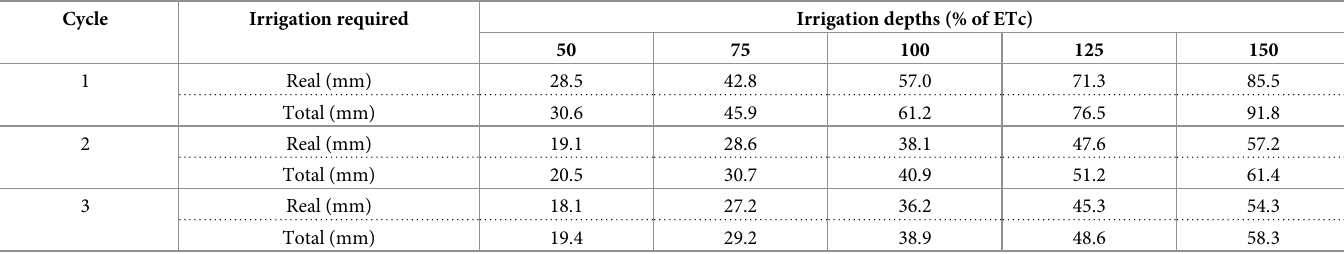
Table 2. Real and total irrigation required in each treatment and lettuce-growing cycle. Cycle Irrigation